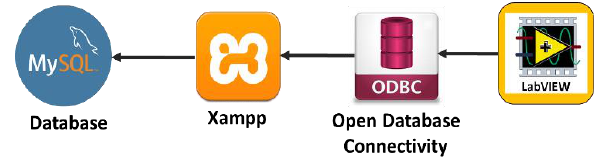
Figure 16. LabVIEW connection with MySQL database.